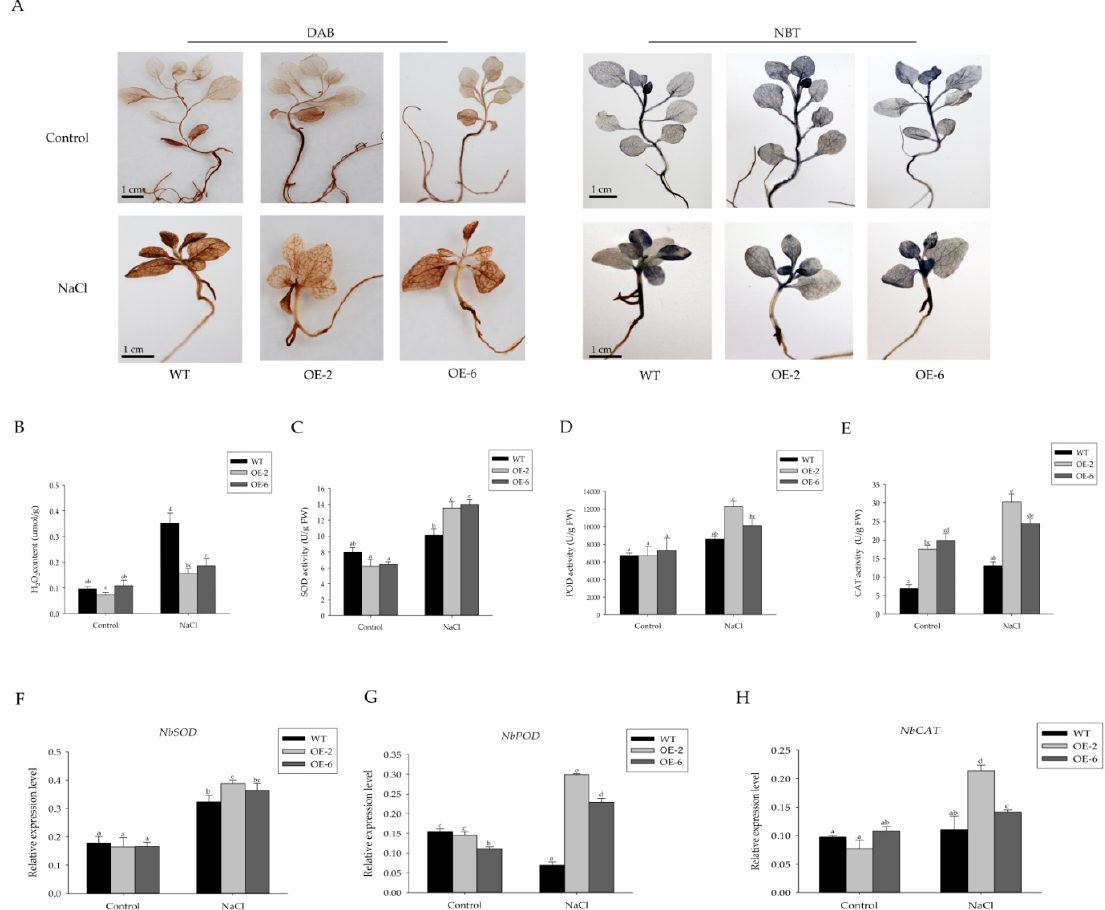
Figure 4. Contents of reactive oxygen species (ROS) in wild type (WT) and miR408-overexpressing Nicotiana benthamiana . ( A ) 3,3-Diaminobenzidine (DAB) and nitroblue tetrazolium (NBT) staining when three-week-old seedlings were treated with 150 mM NaCl for 10 days. The strength of color showed the concentration of H 2 O 2 and O 2 − . ( B ) Contents of H 2 O 2 in tobacco with or without salt treatment. ( C – E ) The activities of SOD ( C ), POD ( D ), and CAT ( E ) in WT and transgenic lines when three-week-old seedlings were treated with 150 mM NaCl for 10 days. ( F – H ) Expression of ROS-responsive genes NbSOD ( F ), NbPOD ( G ), and NbCAT ( H ), determined via RT-qPCR. The data represent means ± SD of three independent experiments. Significant differences were determined using Duncan’s multiple range test (indicated by different letters at p < 0.05).